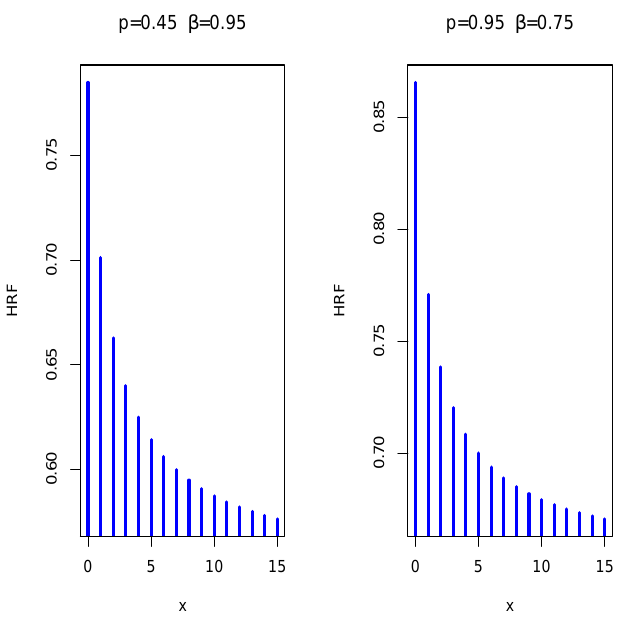
Figure 5. The HRF plots of the DEBuH